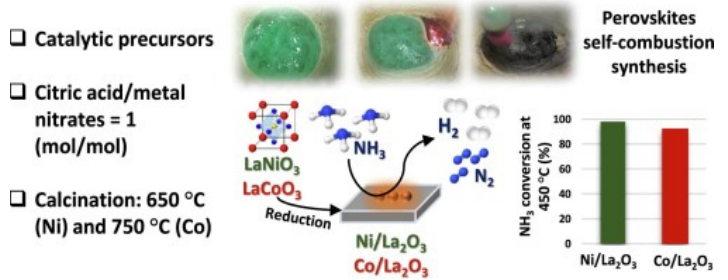
Figure 34. The process of ammonia decomposition over a La-based catalyst consists of calcined nickel and cobalt [131].